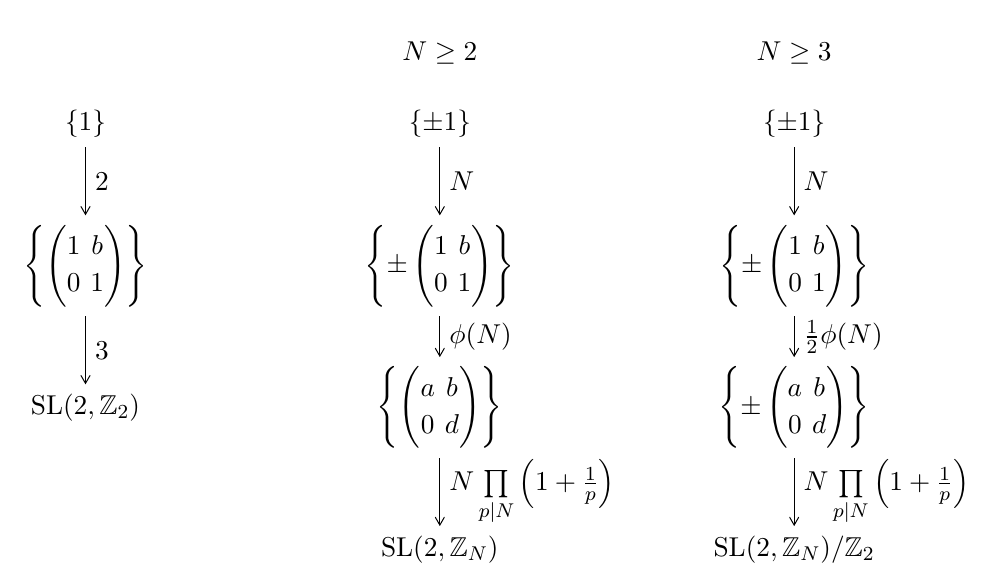
Figure 13 . Galois Groups associated to the congruence subgroups of (cid:12)gure 12. The group denoted f(cid:6) 1 g at the top is the trivial group (of cardinality 1) inside SL(2 ; Z N ) = Z 2 . The letters a; b; d denote generic elements in Z N , and all matrices have unit